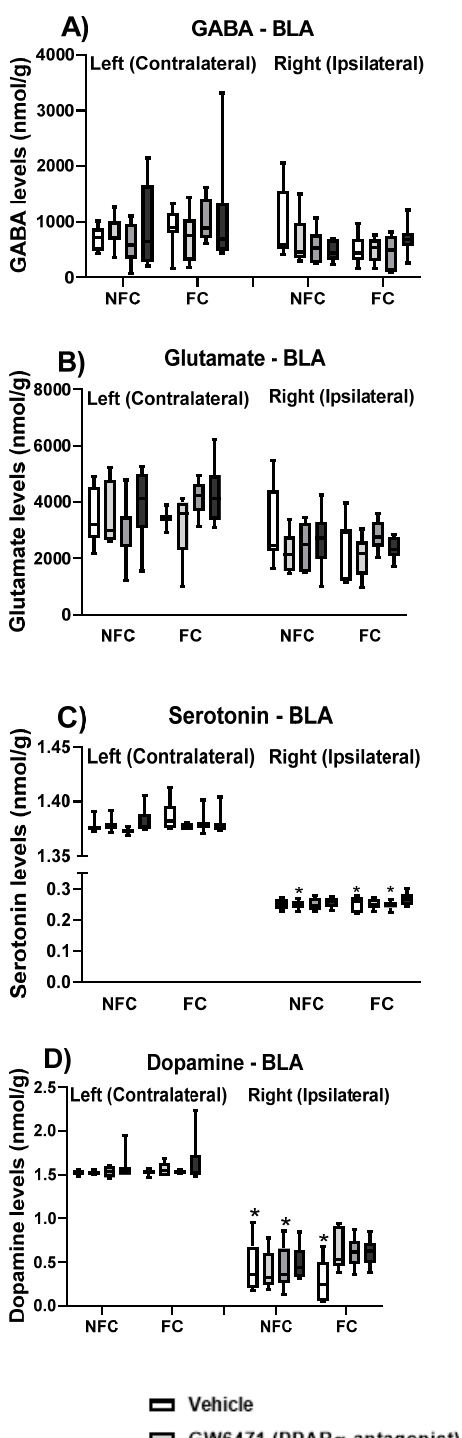
Figure 6. Effects of fear-conditioning and intra-BLA administration of PPAR α , PPAR β / δ , and PPAR γ antagonists on the levels of GABA ( A ), glutamate ( B ), serotonin ( C ), and dopamine ( D ). Post hoc analysis indicated that dopamine levels were significantly lower in the right BLA of NFC Vehicle, FC Vehicle, and NFC GSK0660 rats compared to their left counterparts (* p < 0.05). Post hoc analysis also indicated that levels of serotonin were lower in the right BLA of NFC GW6471, FC Vehicle, and FC GSK0660 rats compared to their left side counterparts (* p < 0.05). Data are expressed as the median with interquartile range and min/max ( n = 7–9 rats per